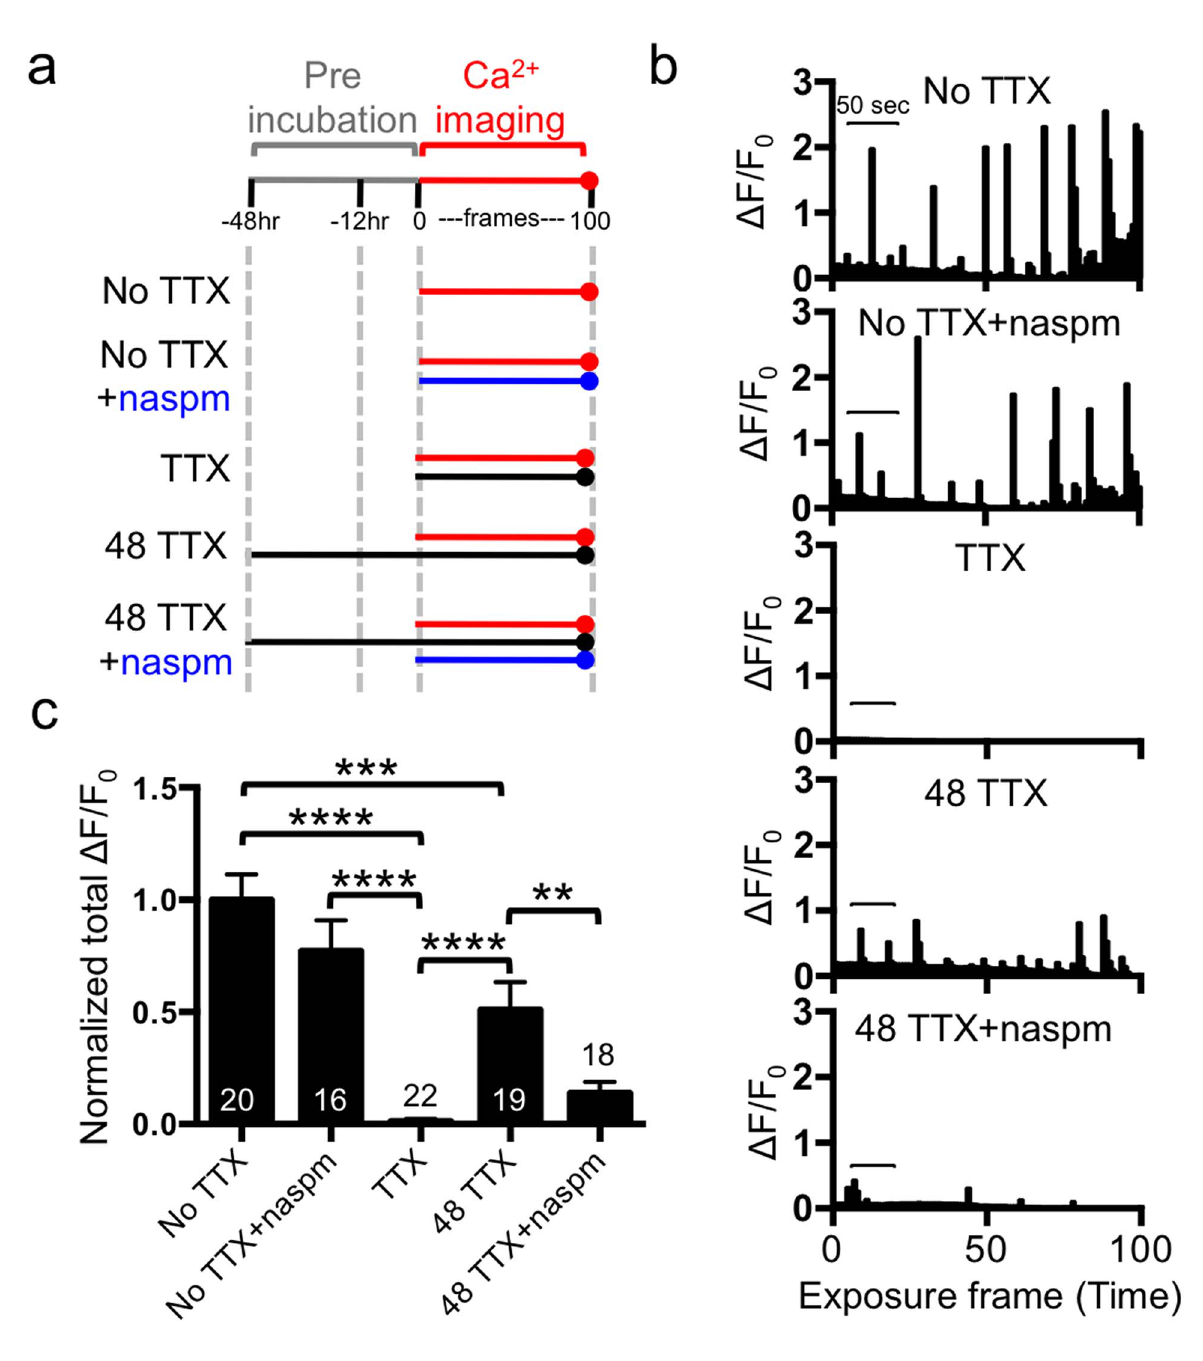
Figure 7. Synaptic scaling restored Ca 2 + signals via TTX-induced CPARs. (a) Schematic of Ca 2 + imaging protocol. A red line indicates Ca 2 + imaging, a black line represents the presence of TTX, and a blue line shows the addition of naspm. (b) Example bar graphs of Ca 2 + activity in each condition. Each bar represents the GCaMP5 fluorescence intensity detected in a single exposure frame. Scale bars are 50 s. (c) Normalized average of total Ca 2 + activity in each condition ( n =number of neurons, ** p , .01, *** p , .001, and **** p , .0001, one-way ANOVA, uncorrected Fisher’s